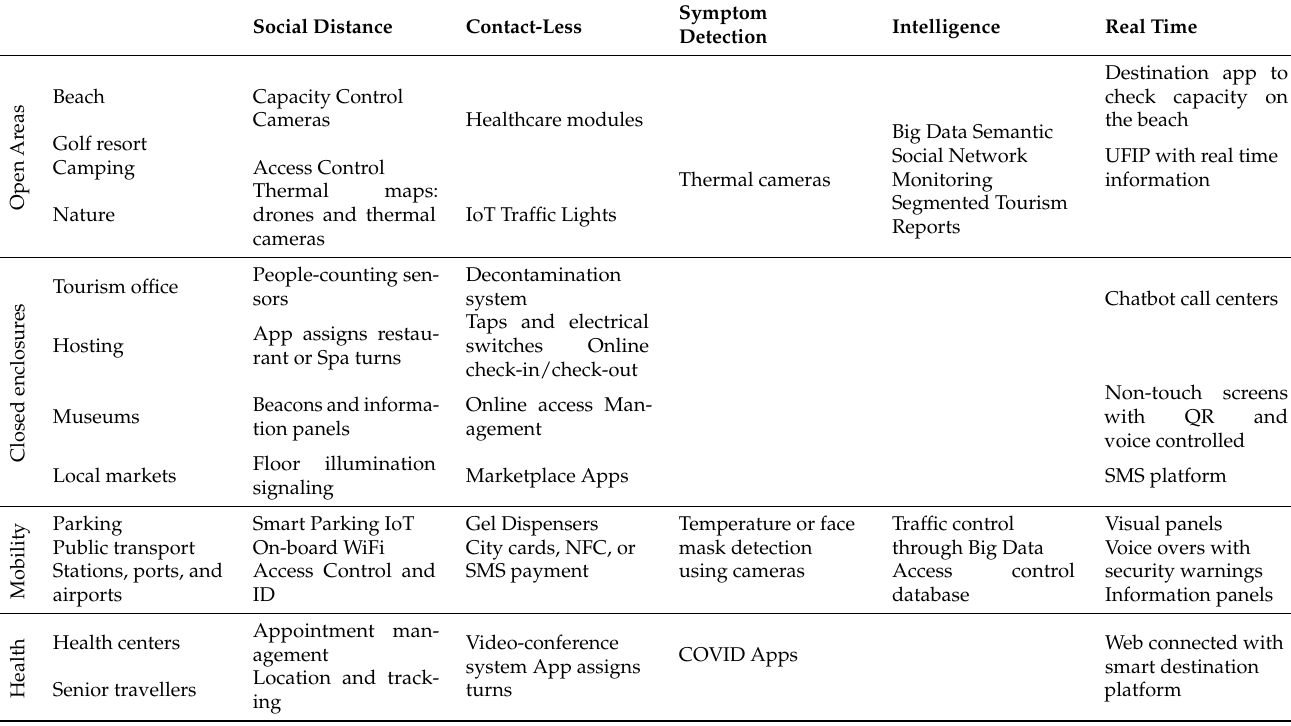
Table 2. Safe destination matrix developed from the work in